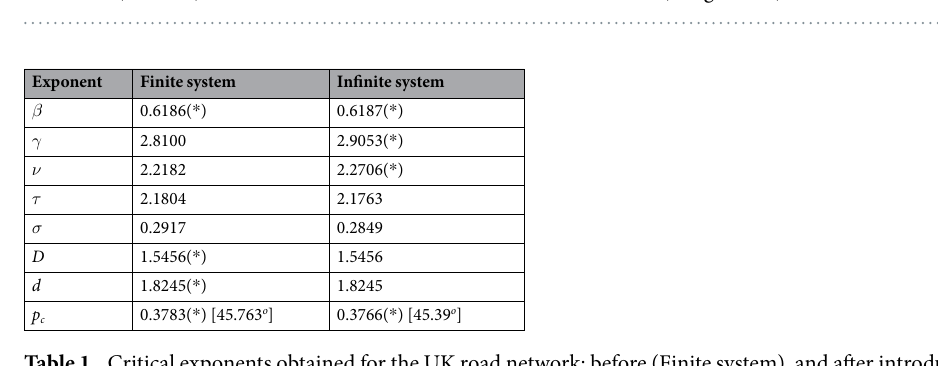
Table 1. Critical exponents obtained for the UK road network: before (Finite system), and after introducing corrections (Infinite system) due to the finite size of the system. The values marked with ( * ) are the ones that have been calculated from the experimental results, the rest of the exponents were calculated by using the scaling relationships between the